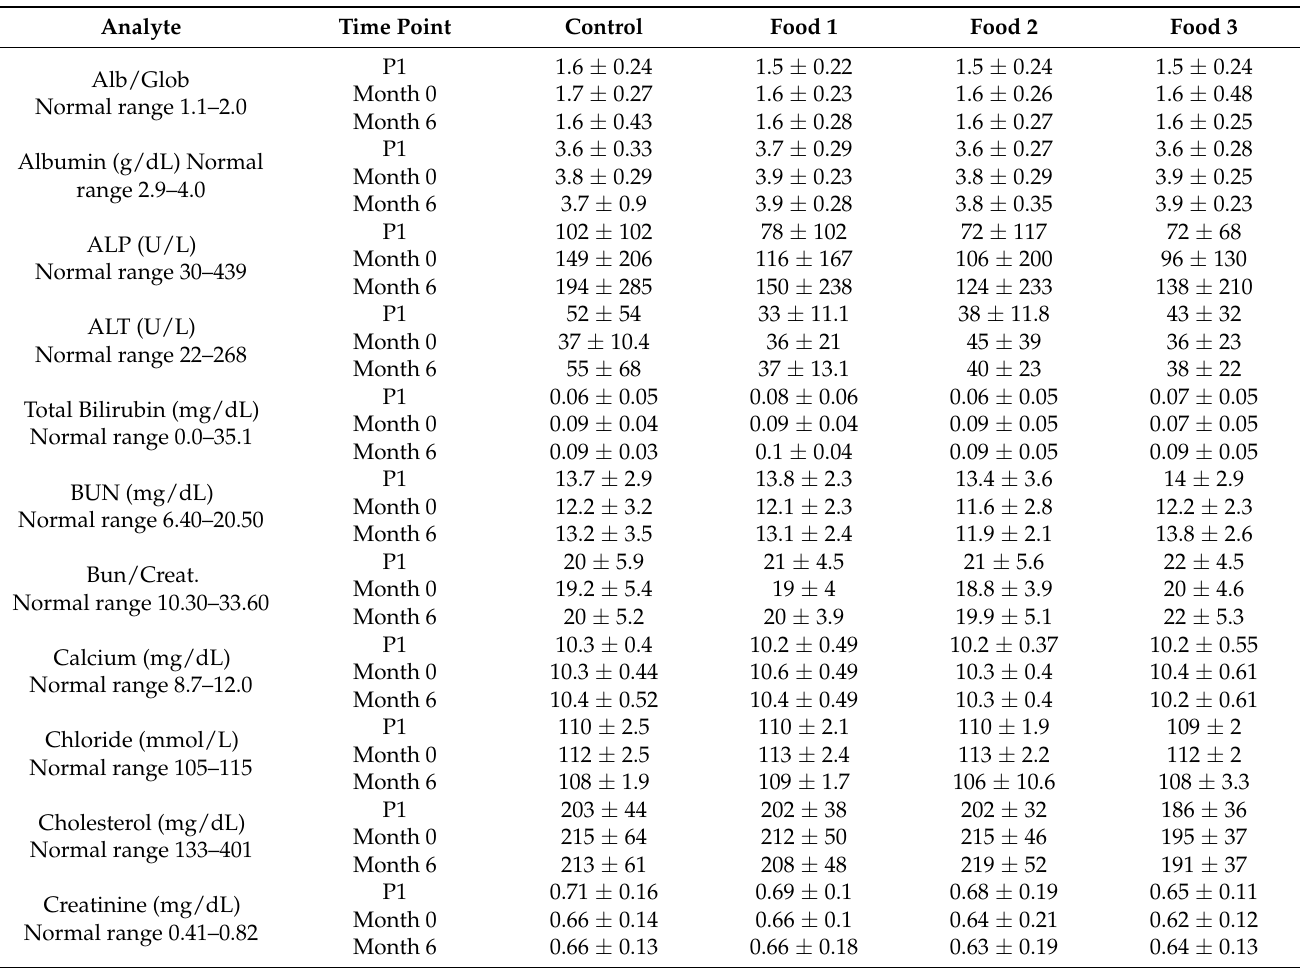
Table A3. Complete serum chemistry